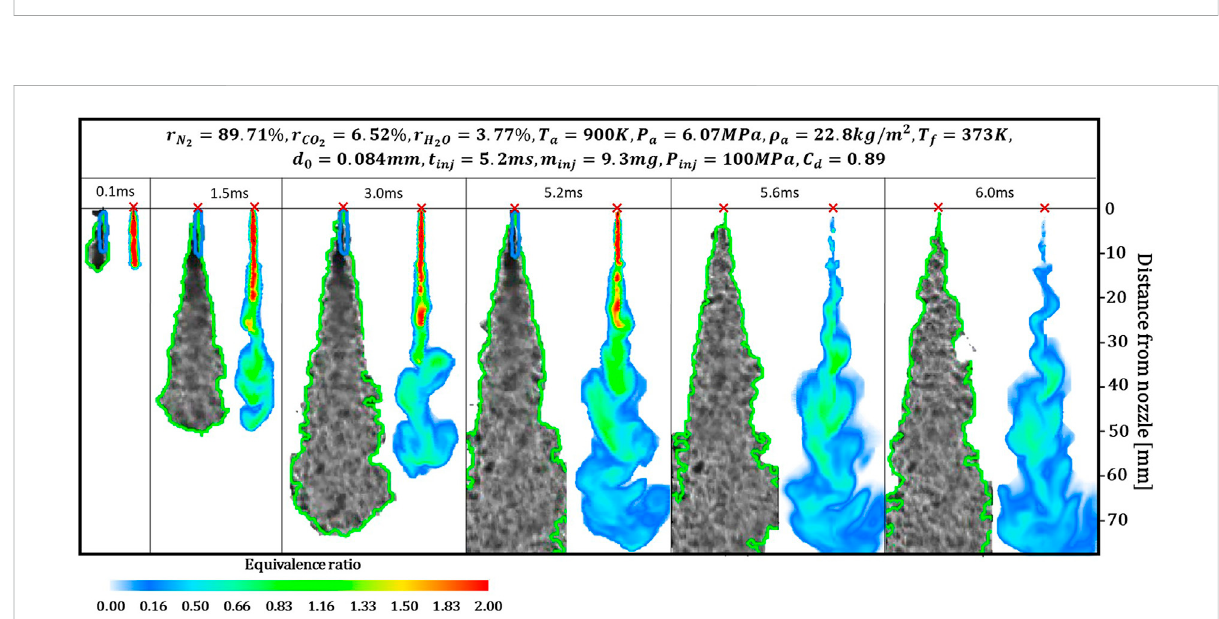
FIGURE 5 Spray shapes and equivalence ratio histories of case injection pressure: 100